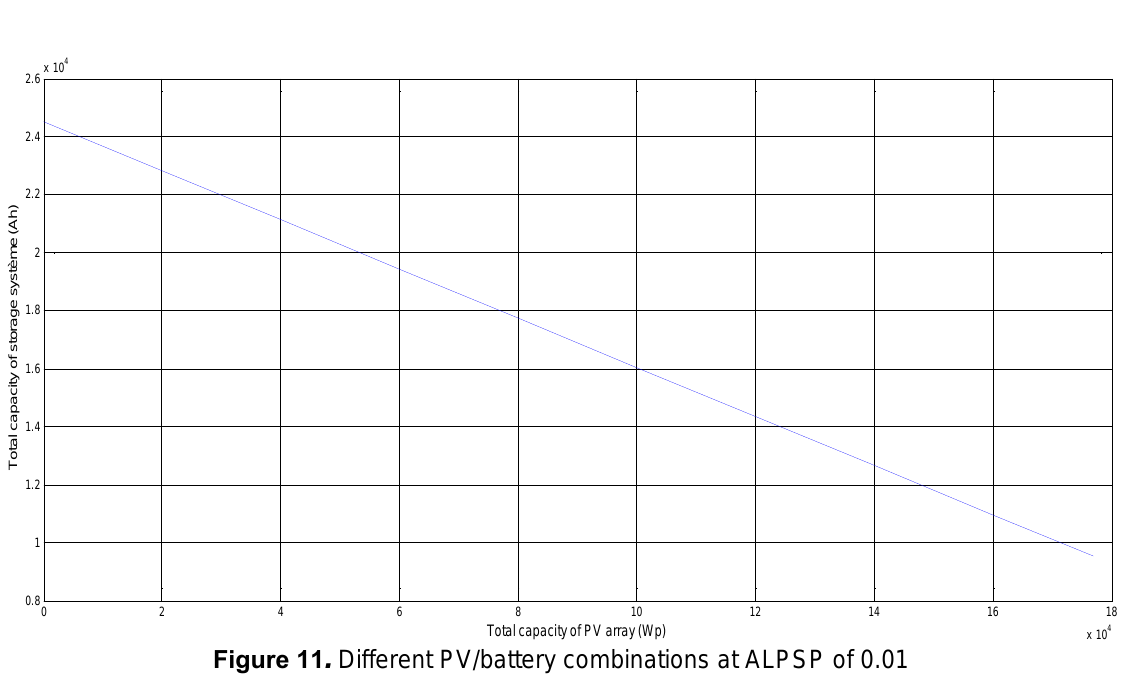
Figure 11 . Different PV/battery combinations at ALPSP of 0.01